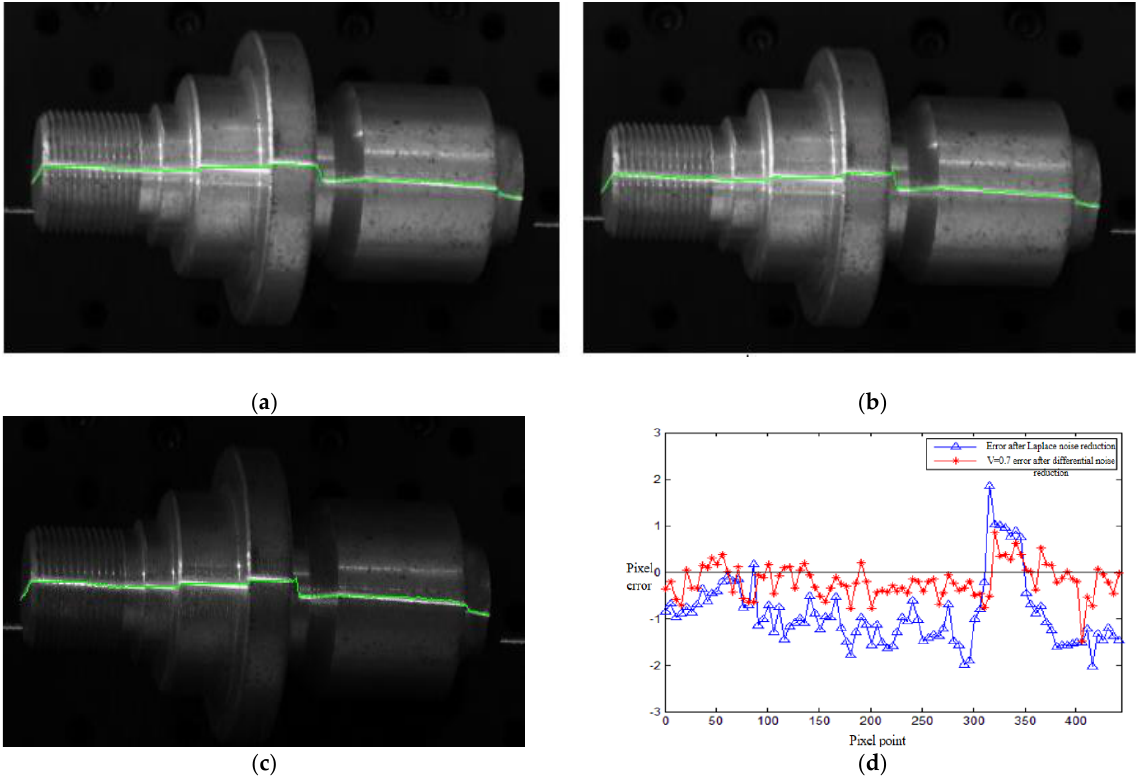
Figure 11. PCB strip center extraction and performance comparison: ( a ) extracting the light stripe center after the Steger method; ( b ) v = 0.7 order differential enhancement extracting the stripe center; ( c ) dark background dark light bar image extraction of the light bar center; ( d ) performance com- parison.